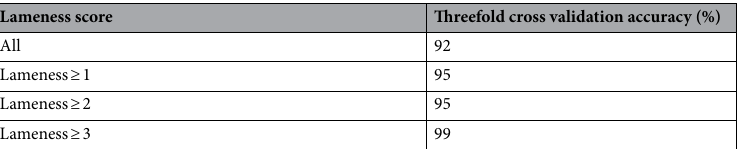
Table 15. Catboost threefold cross validation accuracy for scorer 3 for each of the 3 lameness score groups: separate degrees of lameness, scores 0 as non-lame with scores 1, 2 and 3 as lame, scores 0 and 1 as non-lame with scores of 2 and 3 as lame, scores 0, 1 and 2 as non-lame and a score of 3 as